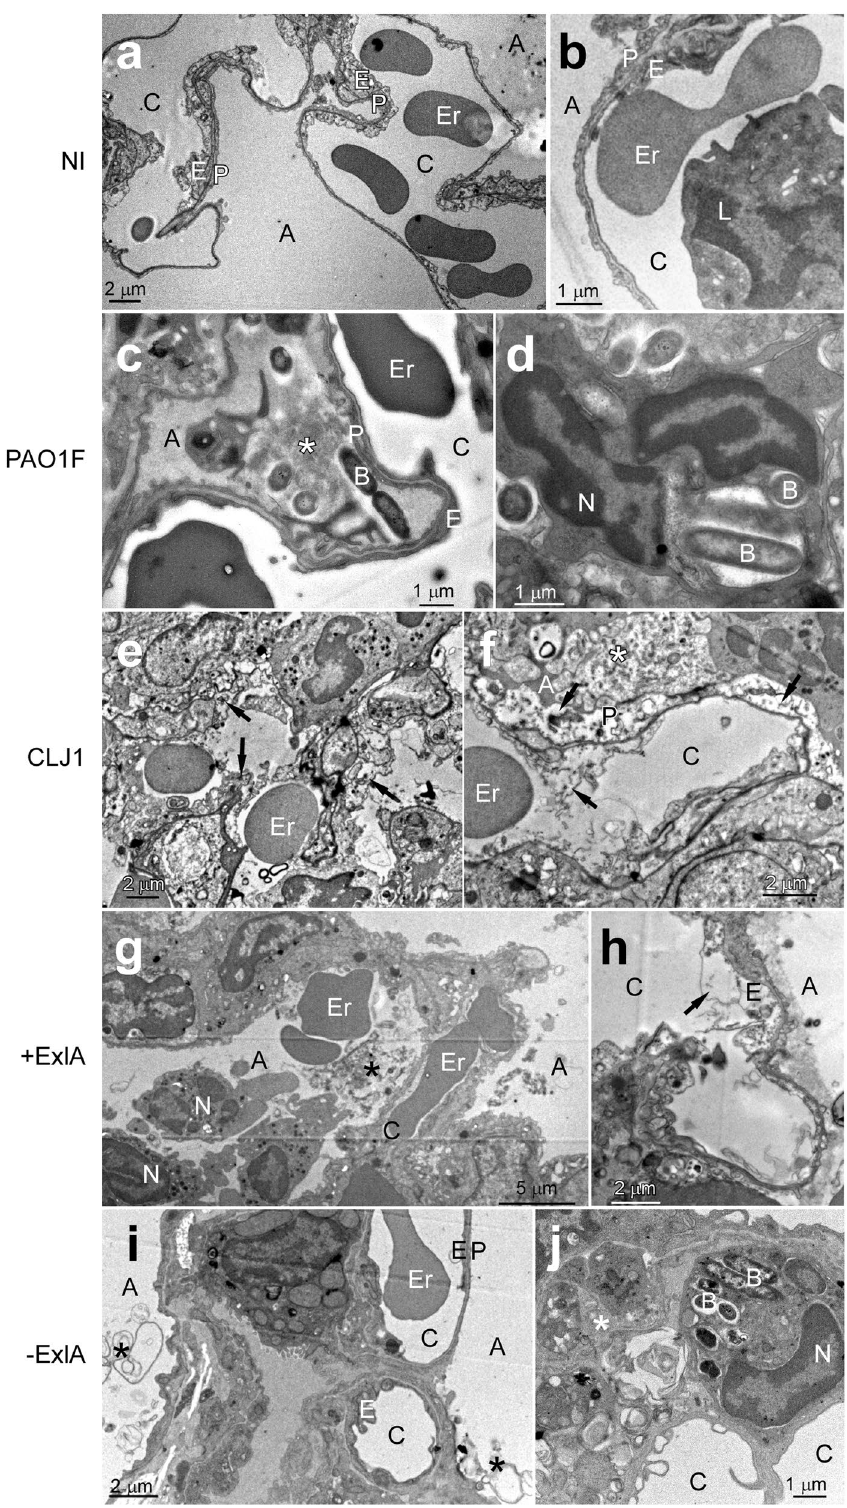
Figure 2. Electron micrographs of infected lungs. ( a – j ) Mice (n = 2 per strain) were infected with 5 × 10 6 bacteria from PAO1F, CLJ1, PAO1F Δ T3SS:: exlBA ( + ExlA) or PAO1F Δ T3SS::empty vector ( − ExlA) strains, or were uninfected (NI), as indicated (2 images per condition). Mice were euthanized at 18 h.p.i. and lungs were isolated and prepared for electron microscopy. Abbreviations: A, alveolus; B, bacterium; C, capillary; E, endothelial cell; Er, erythrocyte; L, leukocyte; N, neutrophil; P, pneumocyte, * intra-alveolus material: mucus, cellular debris, surfactant. Arrows indicate endothelial or epithelial